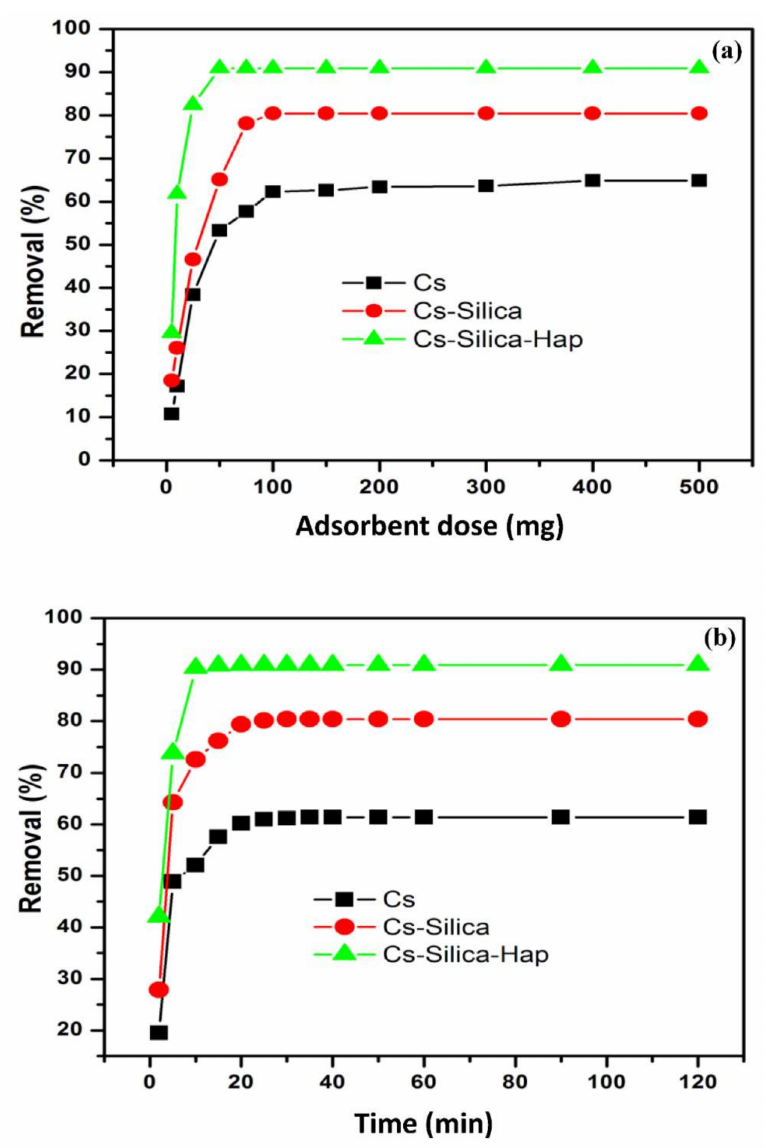
Figure 6. Adsorbent dose ( a ), and contact time ( b ) plots for Cr(VI) adsorption on Cs and Cs based